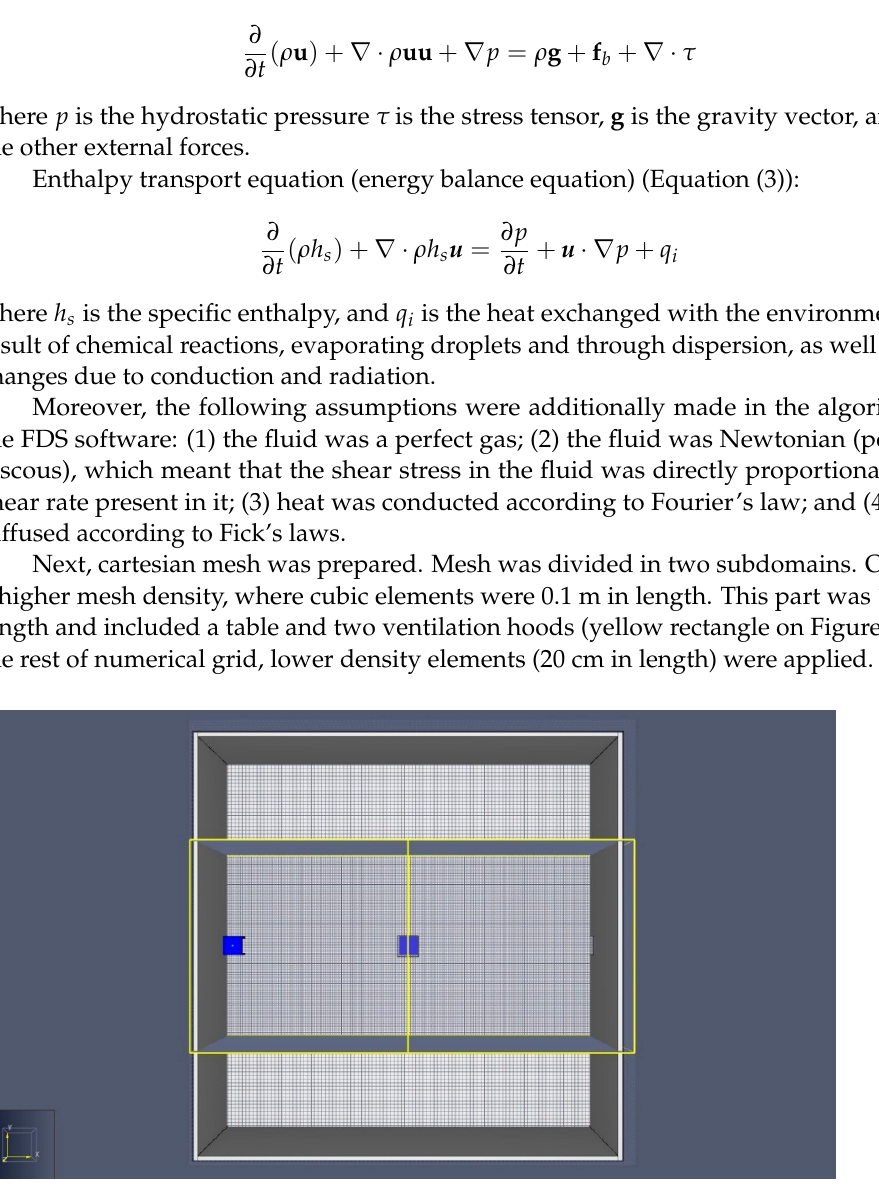
Figure 3. Numerical mesh created in Fire Dynamics Simulator (FDS) with two subdomains. Yel- low rectangle indicates the main part of analyzed industrial hall where tables and ventilation hoods were located.